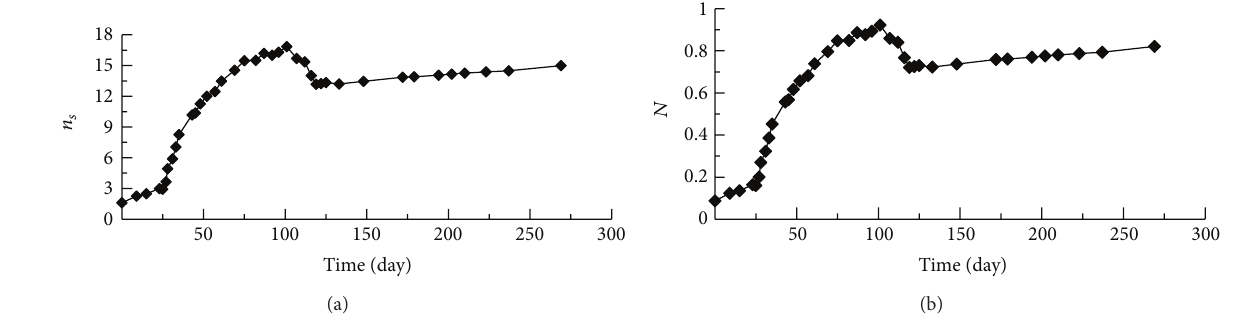
Figure 18: Variation of pile-soil stress ratio 𝑛 𝑠 and shared load ratio 𝑁 .